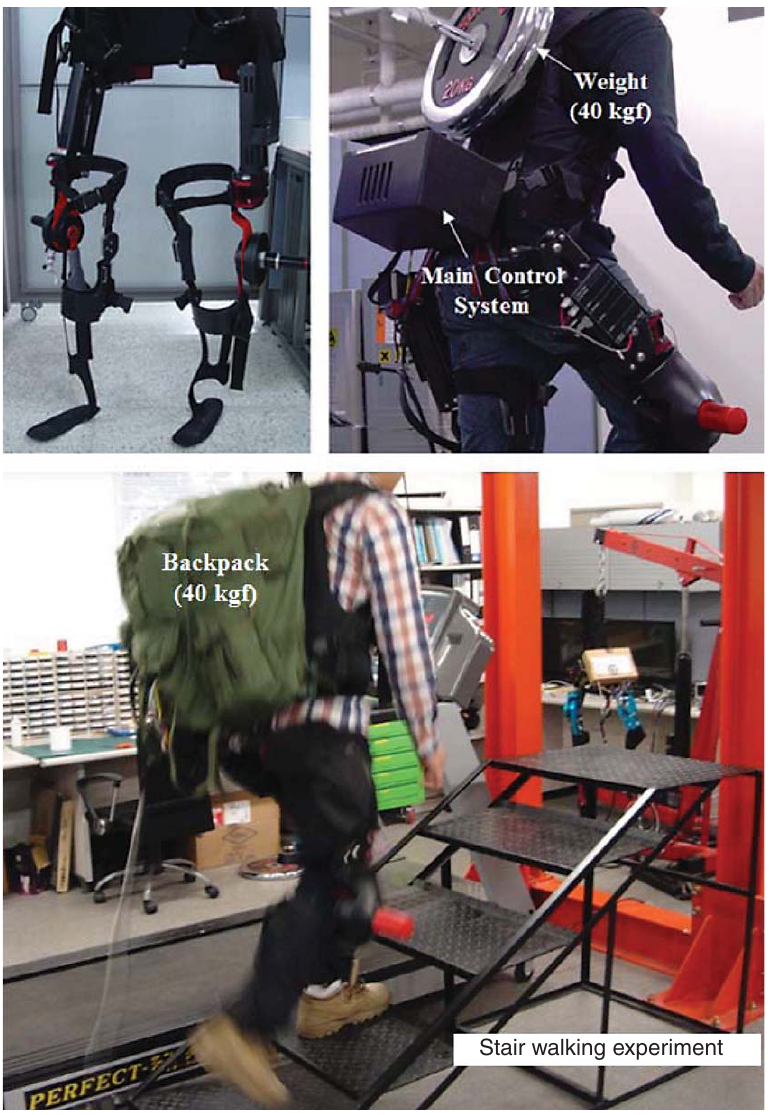
Fig. 11. Evaluation of the walking performance of the exoskeleton system (40 kgf of weight